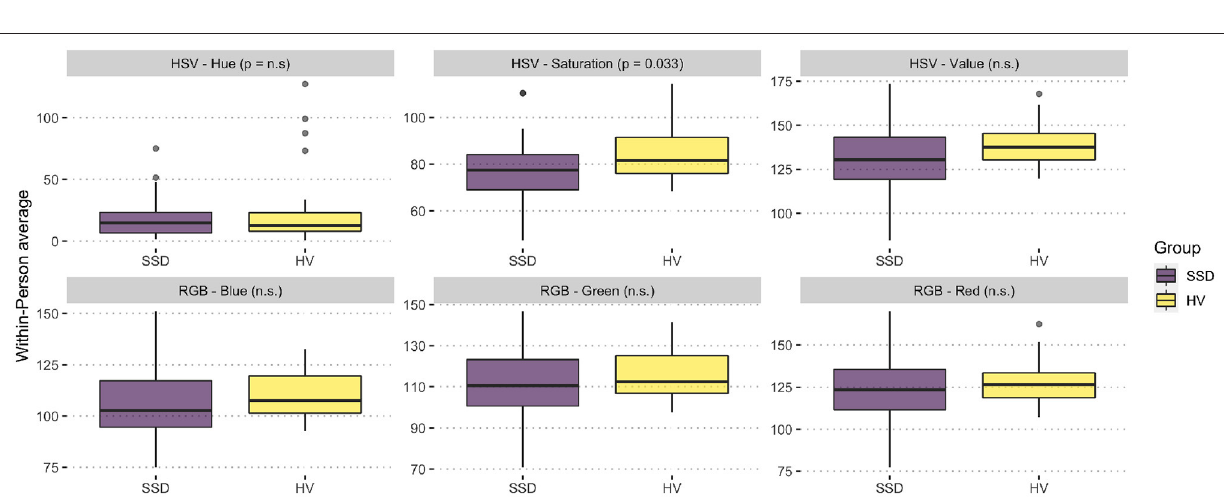
0.05); U = 426, n 1 = n 2 = 34, p = 0.091. Since the default aspect 605.5, n 1 = n 2 = 34, p = 0.438; SSD: mean = 44.8%, SD = 28.8; HV: mean = 34.3%, SD =